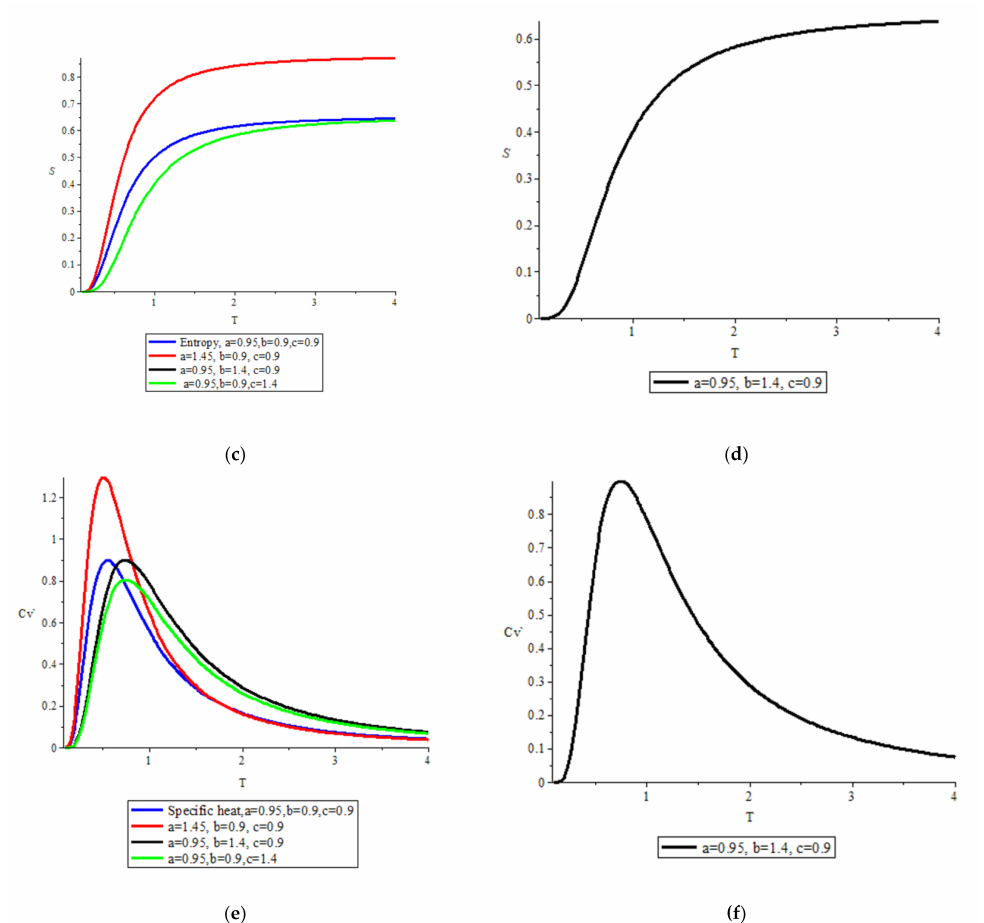
Figure 3. The temperature evolution for different values of parameters of the thermodynamic functions calculated by the Hamiltonian of Equation (1) within the pseudospin representation of Section 2 (a,b,c are a , α , A , respectively, in Equations (7)–(9)). ( a ) represents the thermodynamical potential for the data given in legend; ( b ) the internal energy; ( c ) entropy; ( d ) entropy corresponding to the data that appear in the legend of the graph; ( e ) specific heat; ( f ) specific heat corresponding to the data that appear in the legend of the graph. More explanations in text.